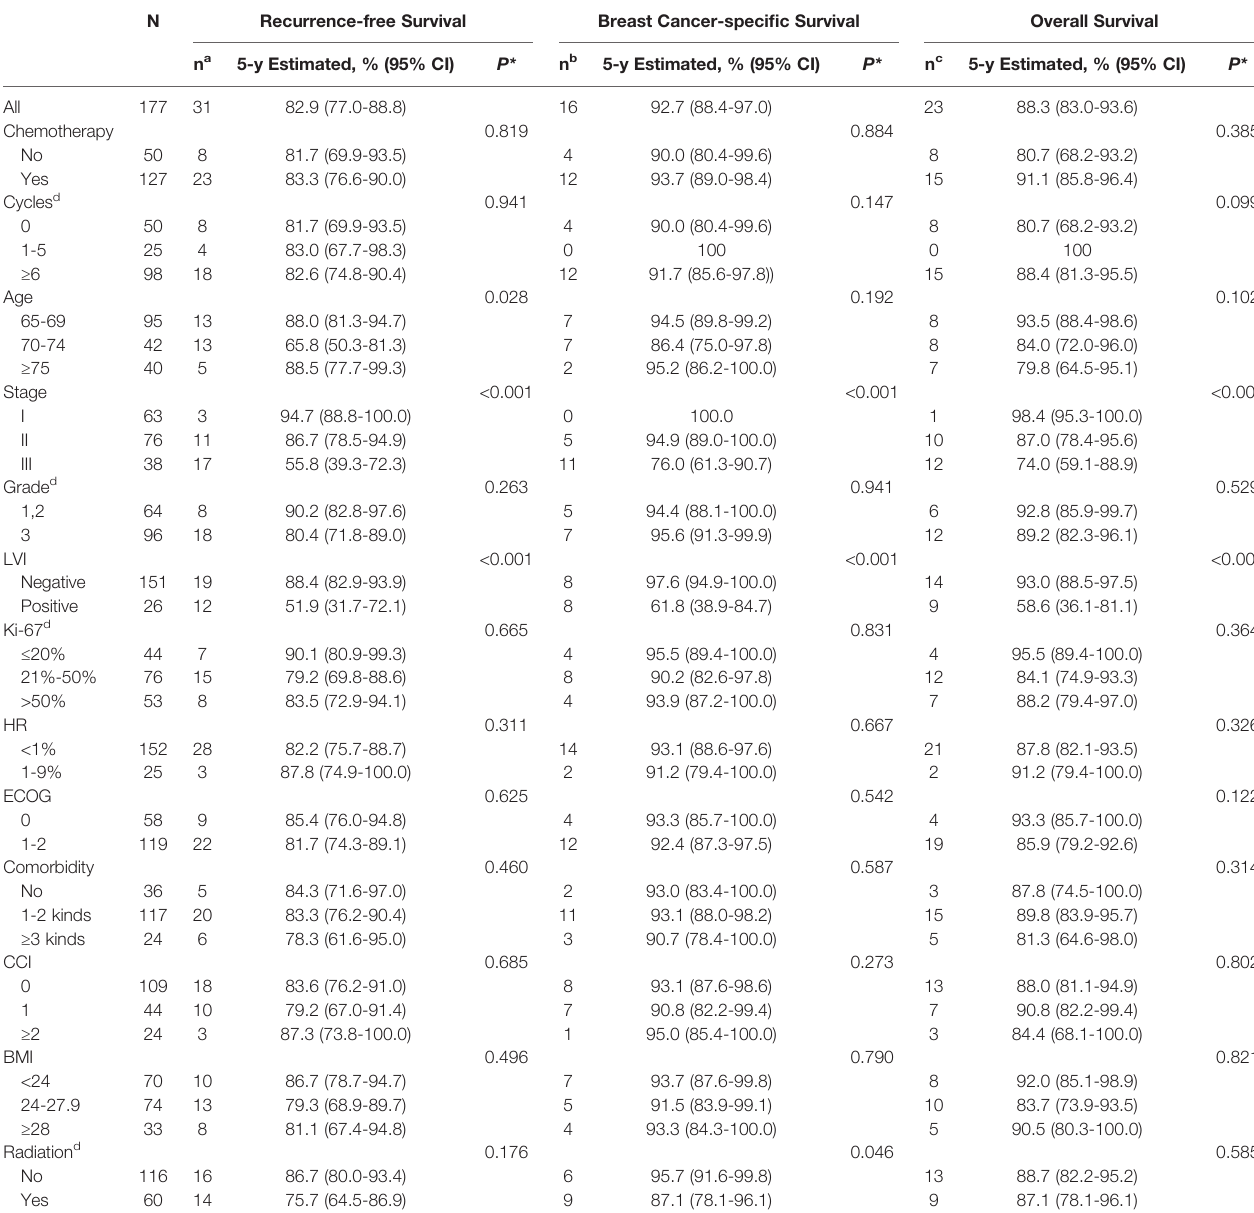
TABLE 3 | Univariate analysis of association between clinical factors and 5-year survival outcomes in 177patients. N Recurrence-free Survival Breast Cancer-speci fi c Survival Overall Survival n a 5-y Estimated, % (95%